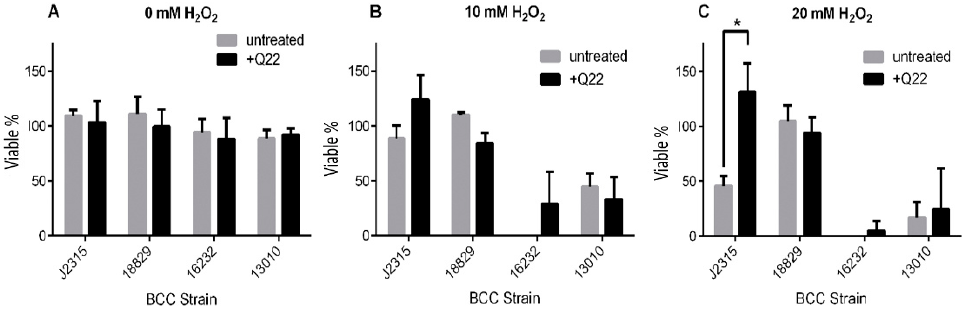
Figure 2. Survival of B. cepacia complex (BCC) strains exposed to H 2 O 2 in vitro. Late-stationary-phase cells were treated with varying concentrations of H 2 O 2 , 0 mM ( A ), 10 mM ( B ), and 20 mM ( C ), as described under Section 4. Samples were plated in triplicate for colony counts, and percentage survival (expressed as % viability) was calculated relative to colony counts of untreated bacteria. * p < 0.05. Isolates included B. cenocepacia LMG16656 (J2315), B. cenocepacia LMG18829, B. multivorans LMG13010, and B. vietnamiensis LMG16232 (see Table 1).